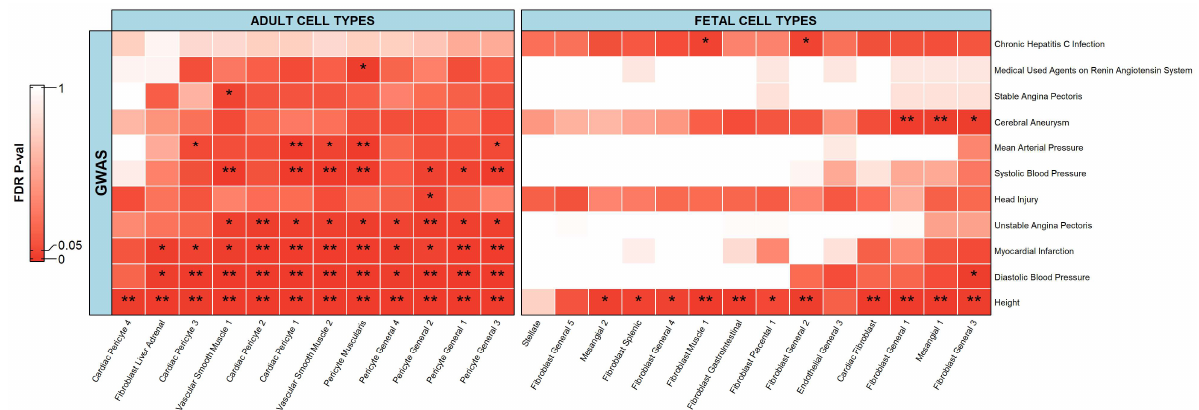
Figure 5. Heatmap depicting associations of stromal cells from adult and fetal tissue cell types with respective phenotypes. The heatmap follows a gradient from red to white as the values go from 0.00 to 1.00. ** represents a significant association with an FDR adjusted p -value less than or equal to 0.01. * represents a significant association with an FDR adjusted p -value less than or equal to 0.05 but greater than 0.01.